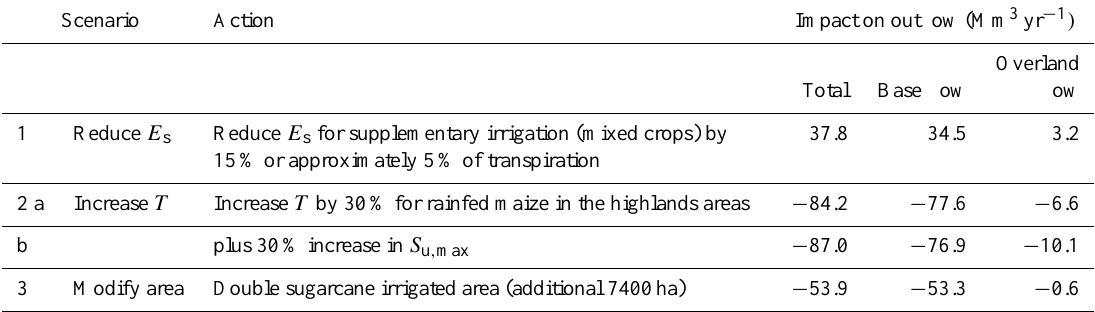
Table 3. Impact of three water management scenarios on the surface